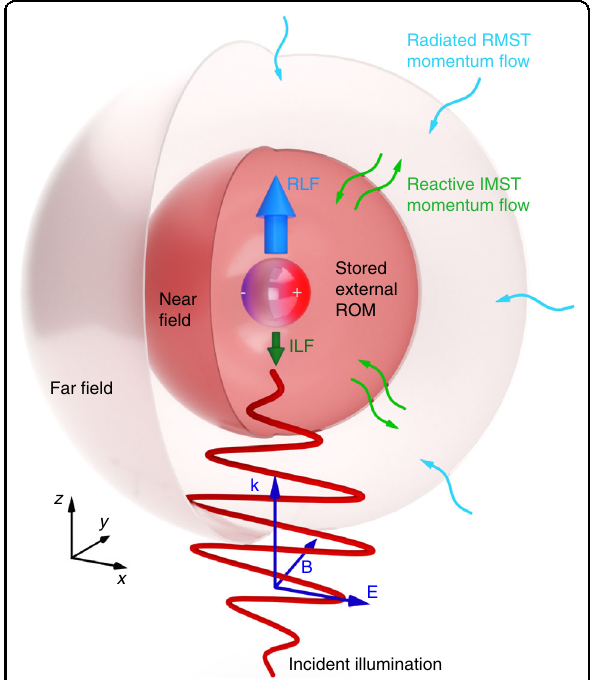
Fig. 1 Outline of the physical process, (the near- fi eld region is enlarged and the radiative area has been shrunk to ease reading). When an electromagnetic wave, (for example a monochromatic plane wave, as illustrated here), impinges on a body, charges are separated, thus inducing multipoles. The object feels a time-averaged Lorentz force, RLF, associated to the fi eld (i.e., Poynting) momentum fl ux, RMST, fl owing into a far- fi eld surface, (e.g., spherical as shown). However, there also appears a fl ow, IMST, of imaginary fi eld momentum, related to momentum fl ux going back and forth across a near- fi eld surface, with zero time-average, which accumulates reactive strength of orbital momentum, ROM, stored both inside and in the near- fi eld of the object, yielding a reactive force, ILF, on the